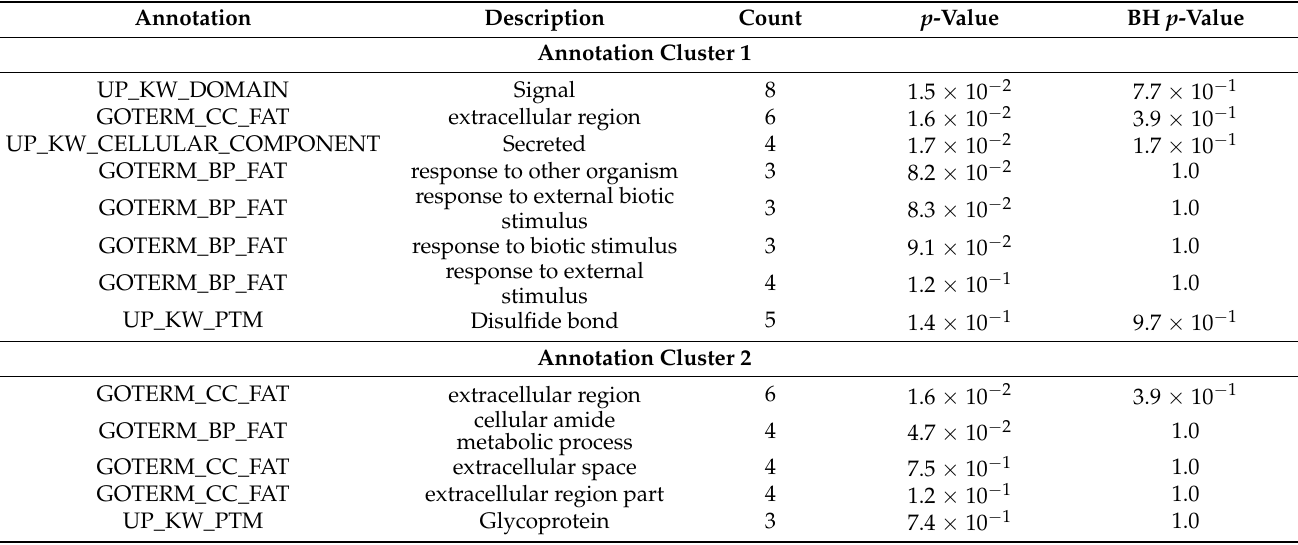
Table 2. Results of DAVID analysis. Clusters with an enrichment score of at least 1 were selected with a raw p -value and Benjamini–Hofberg adjusted metric (BH p -value).